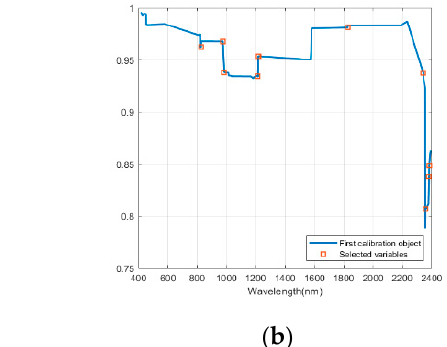
Figure 4. In Daye area, the stable competitive adaptive reweighting sampling algorithm coupled the successive projections algorithm (sCARS-SPA) is used for characteristic wavelength selection: ( a ) the root mean square error of cross-validation (RMSECV) of the 5-fold cross-validation changes with the increase of the number of sCARS algorithm sample runs; ( b ) the final characteristic wavelength and reflectance selected by SPA.